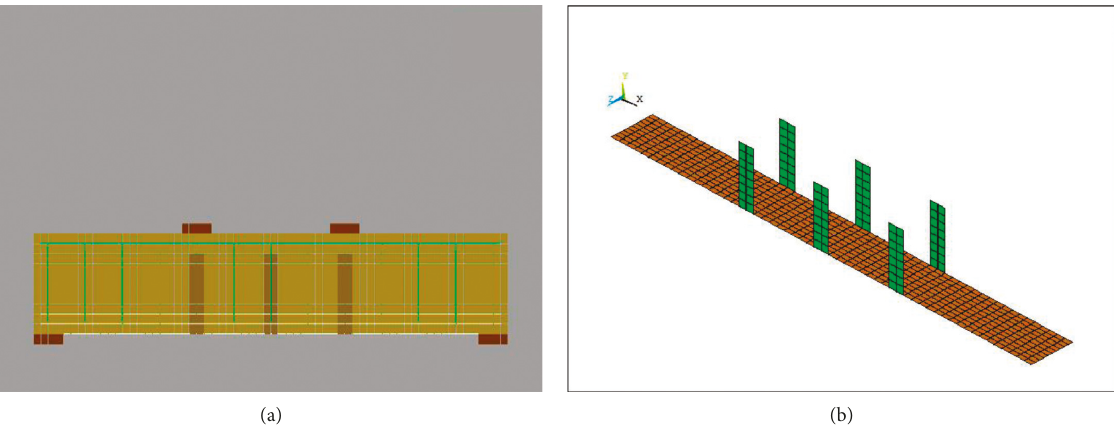
Figure 4: (a) Models B3, B4, and B5 using the midspan wrapping technique and (b) the BFRP